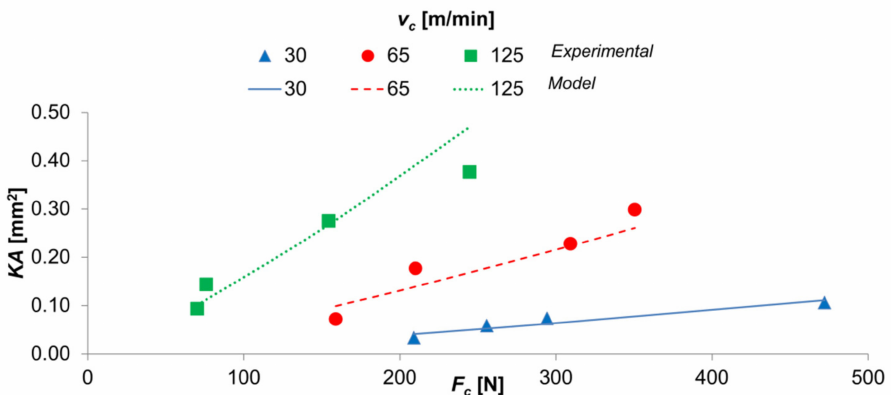
Figure 11. Experimental data vs. parametric model for KA = f ( v c , F c